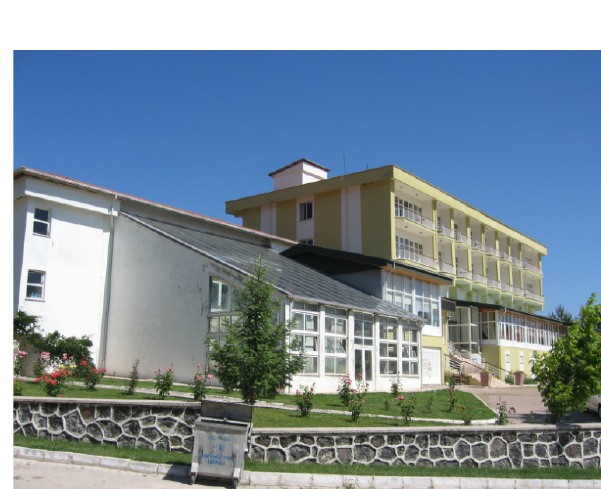
Fig. 6. Three damage types from epicenter region.